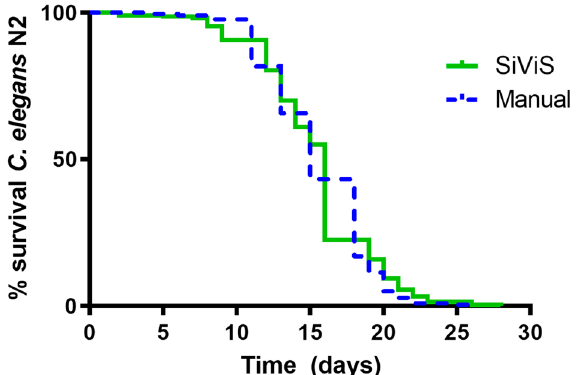
Figure 5. Manual-automated comparison for N2. The graph was obtained with GraphPad Prism v. 4. Comparison of lifespan curves obtained by the automated system and by a manual assay for C. elegans wild- type strain N2. Data from four independent experiments ( n = 200 /condition; 16 plates/condition). To compare